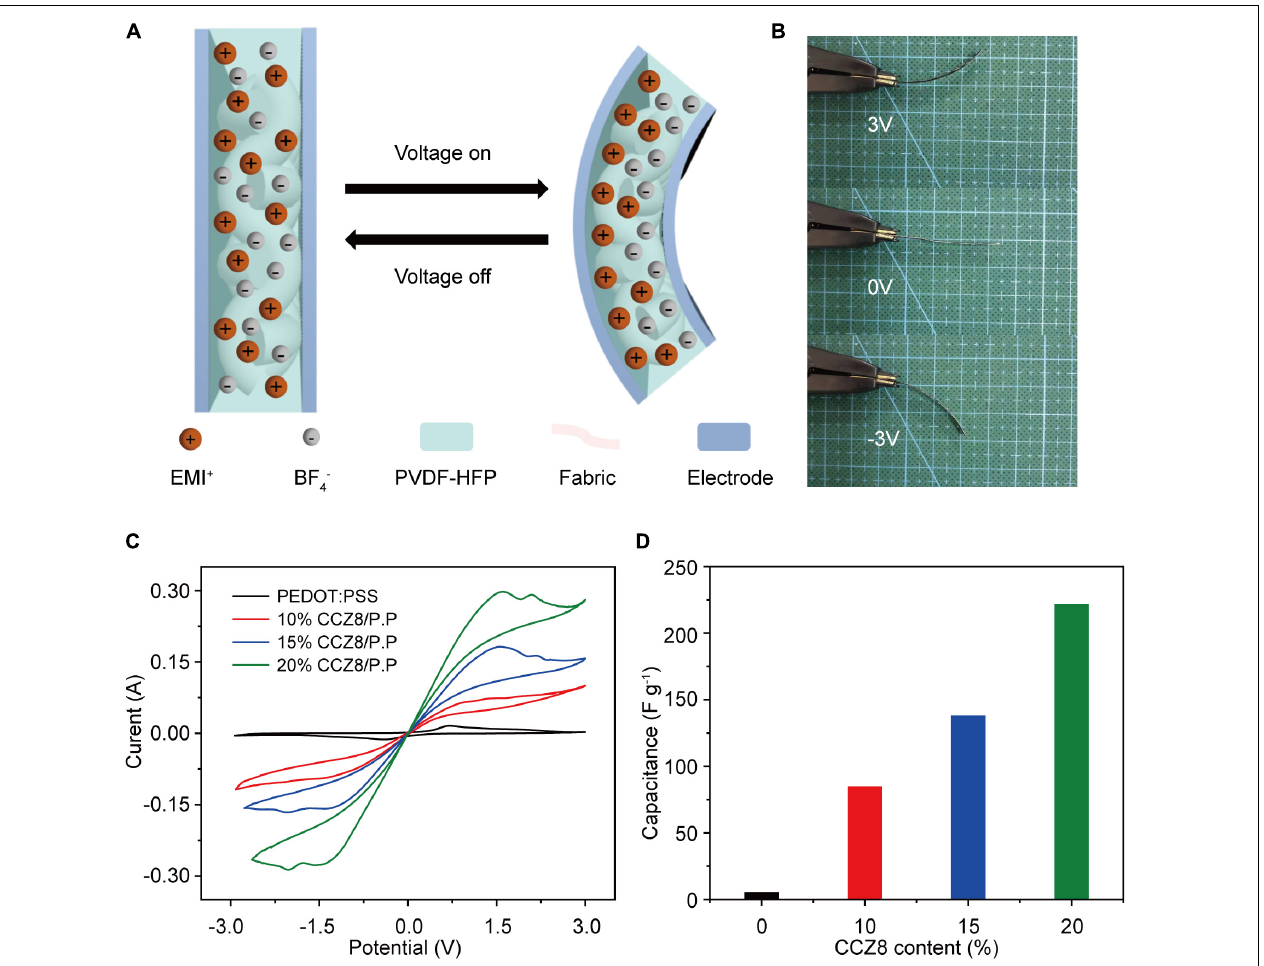
FIGURE 5 | (A) Schematic for actuation mechanism of the textile actuator. (B) Optical images of the bent actuator under 3 V at 0.1 Hz. (C) CV curves for the PEDOT:PSS and CCZ8/P.P electrode based textile actuators at a scan rate of 50 mV s − 1 . (D) The calculated capacitances of textile actuators.